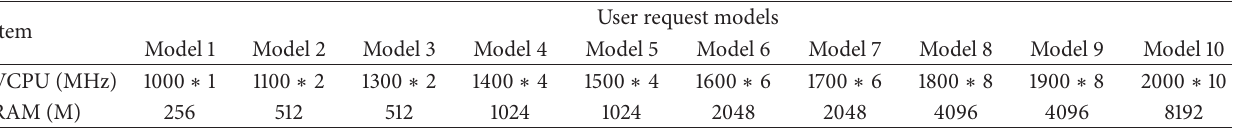
Table 6: VM models for user requests.